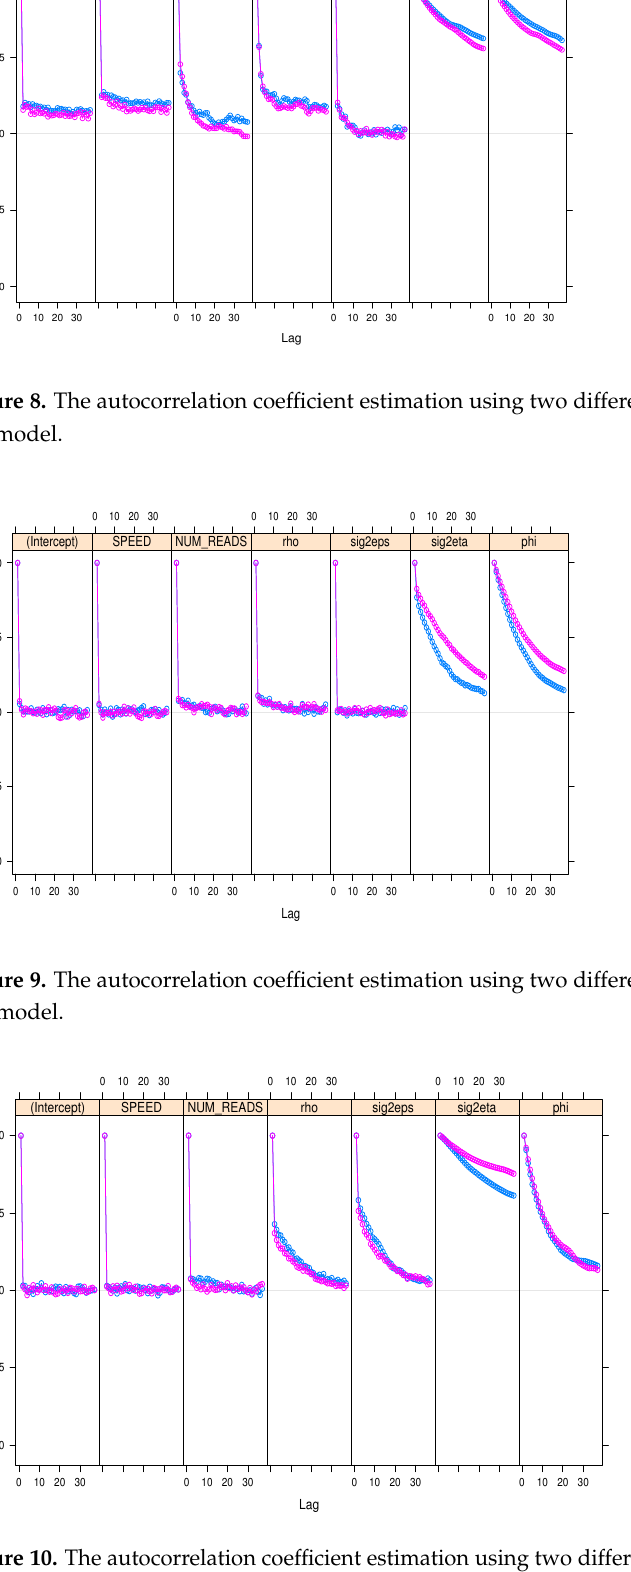
Figure 10. The autocorrelation coefficient estimation using two different lists of MCMC chains in the GPP